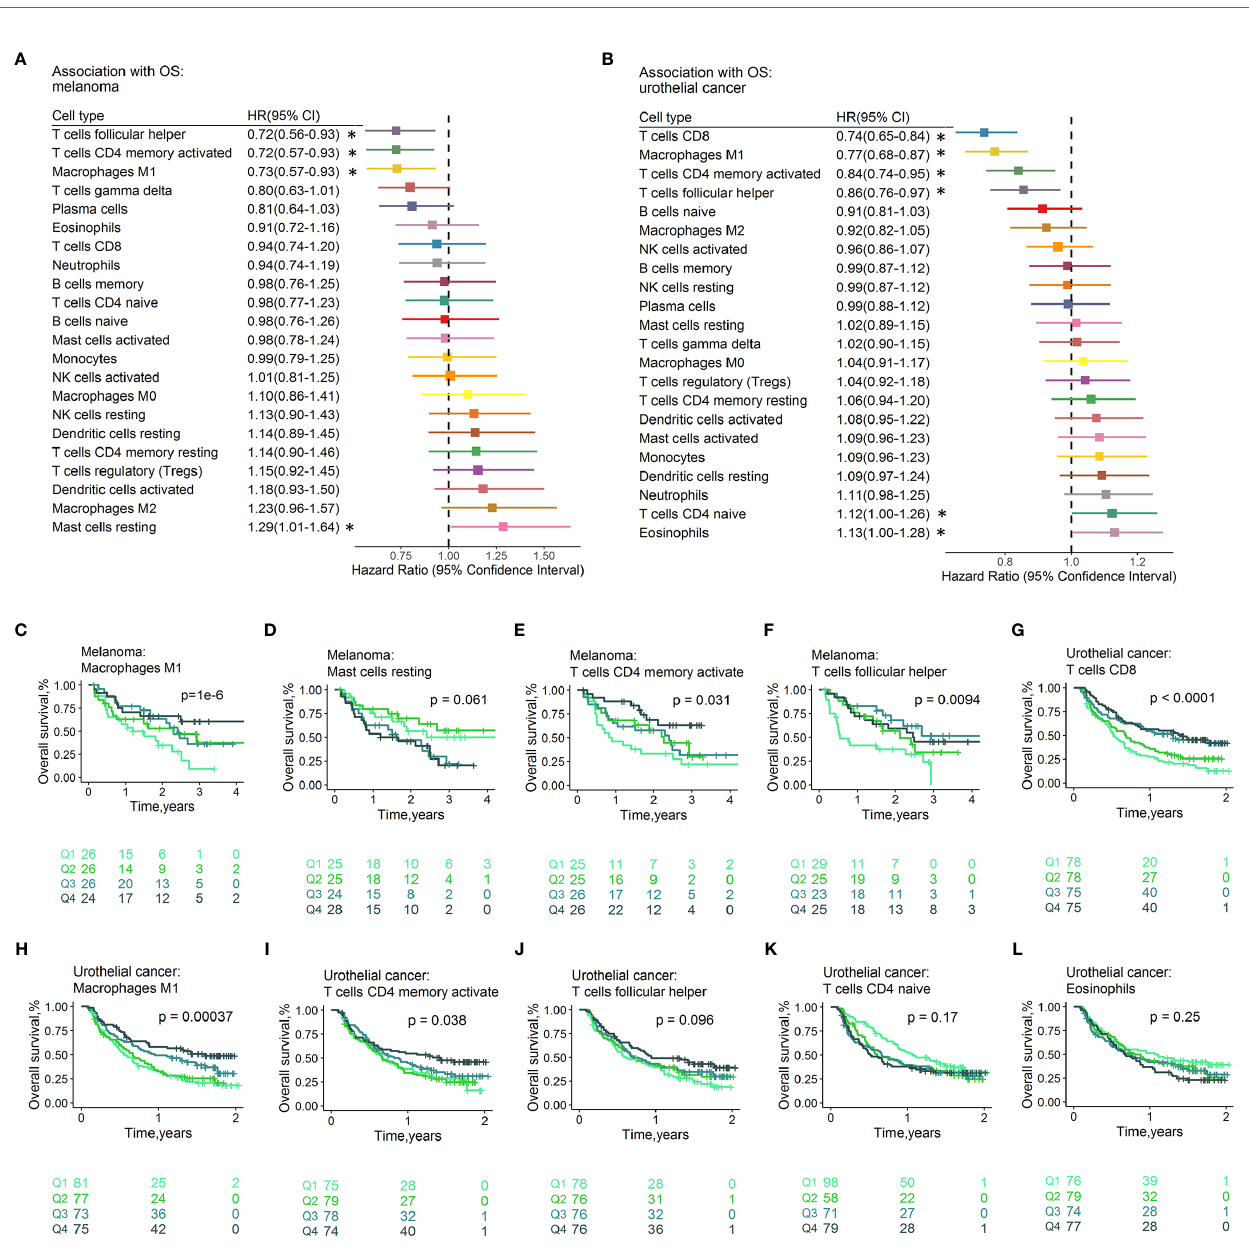
Figure 7G ) and immune phenotype (p<2.2×10 -16 , Figure 7H ). Patients in cluster 4 exhibited a signi fi cantly higher TMB and